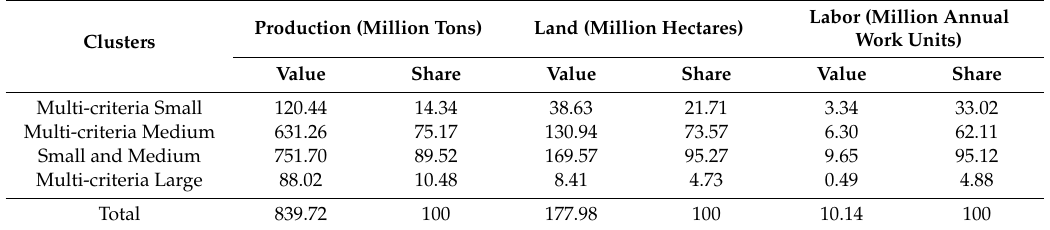
Table 4. Share of the three clusters in (primary) production, land, and labor across Europe; Source: [34] and own calculations.